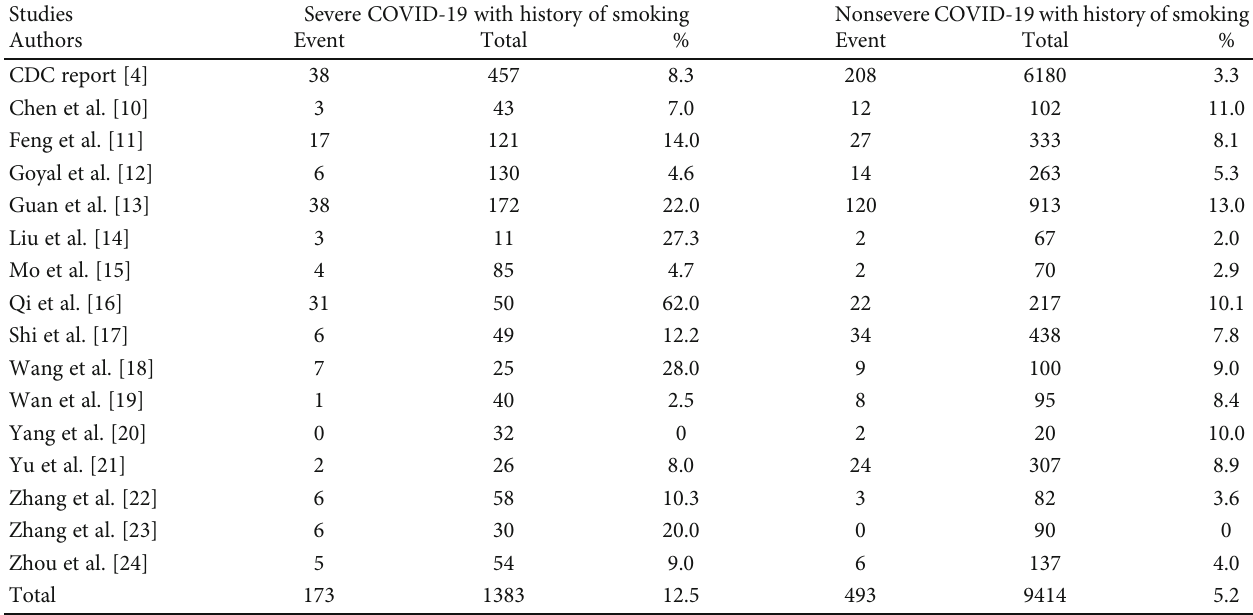
Table 3: The relationship between history of smoking and the severity of